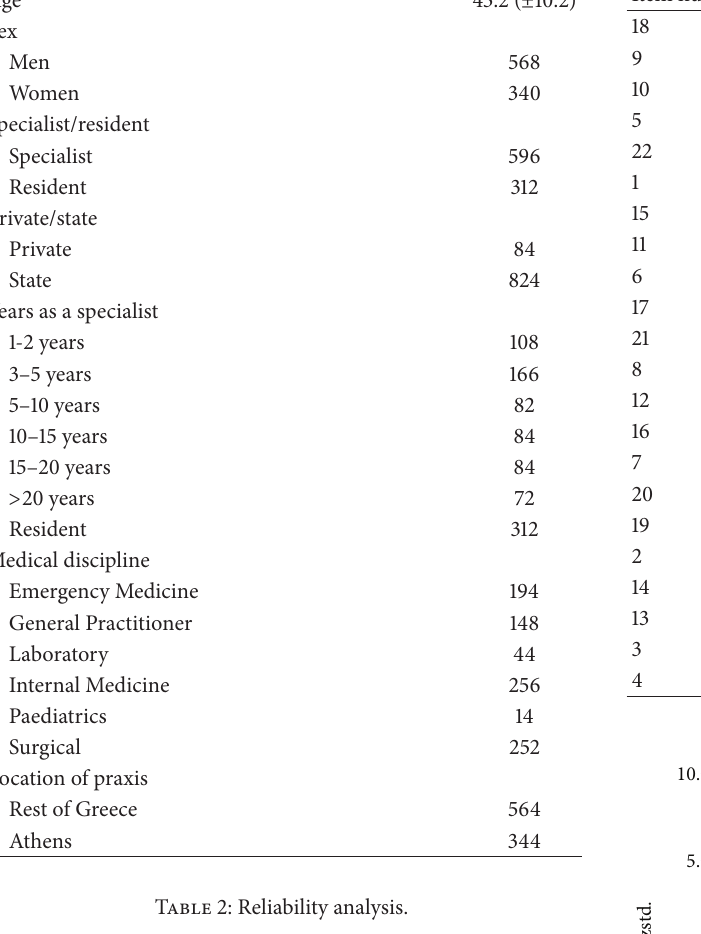
Table 2: Reliability analysis.